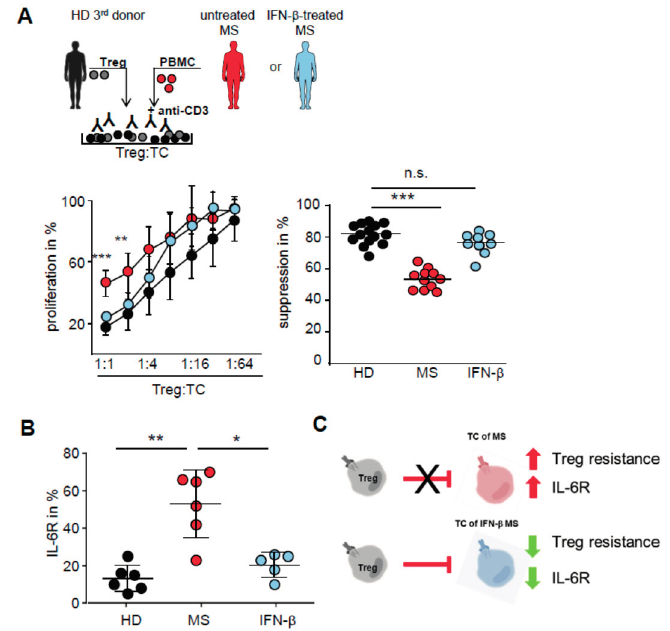
Figure 4. IFN- β therapy restores T cell responsiveness to Treg control. ( A ) Treg-depleted PBMC from therapy-naive (red), IFN- β -treated (blue) MS patients or HD (black) were cocultured with or without Treg from an independent HD and stimulated with anti-CD3 mAb. Proliferation was determined by 3H-Tdr incorporation on day three. Middle: curves show percentage of proliferation in presence of different Treg